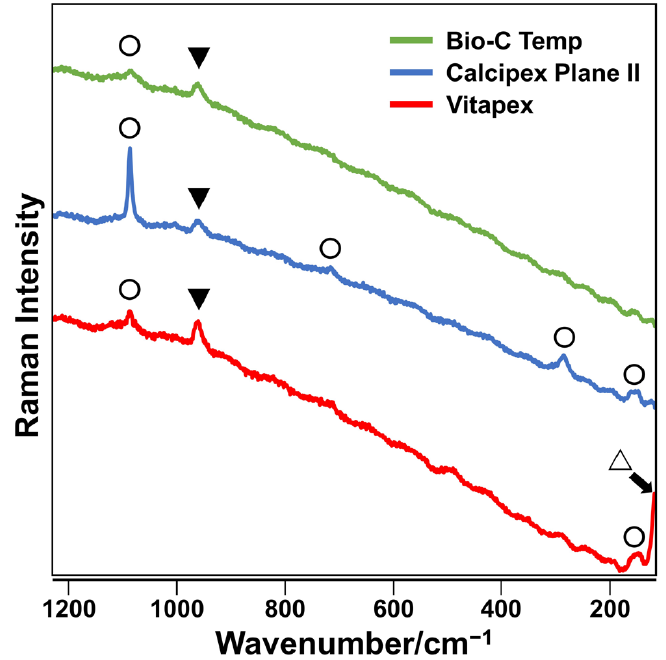
Figure 2. Representative Raman spectra of precipitates formed on the Bio-C Temp, Calcipex Plane II, and Vitapex implants. Bands corresponding to hydroxyapatite ( ▼ ), calcite ( Ȇ ), and iodoform ( △ ) are shown.